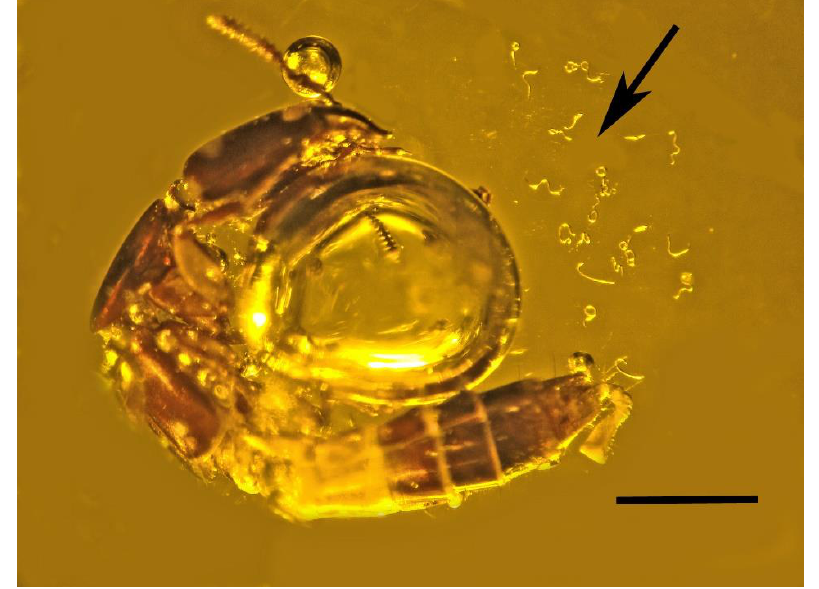
Figure 33. Parasitic juveniles (arrow) of the nematode, Palaeoallantonema dominicana (Nematoda: Allantonematidae) that emerged from their rove beetle (Coleoptera: Staphylinidae) host in Dominican amber. Scale bar = 900µm.